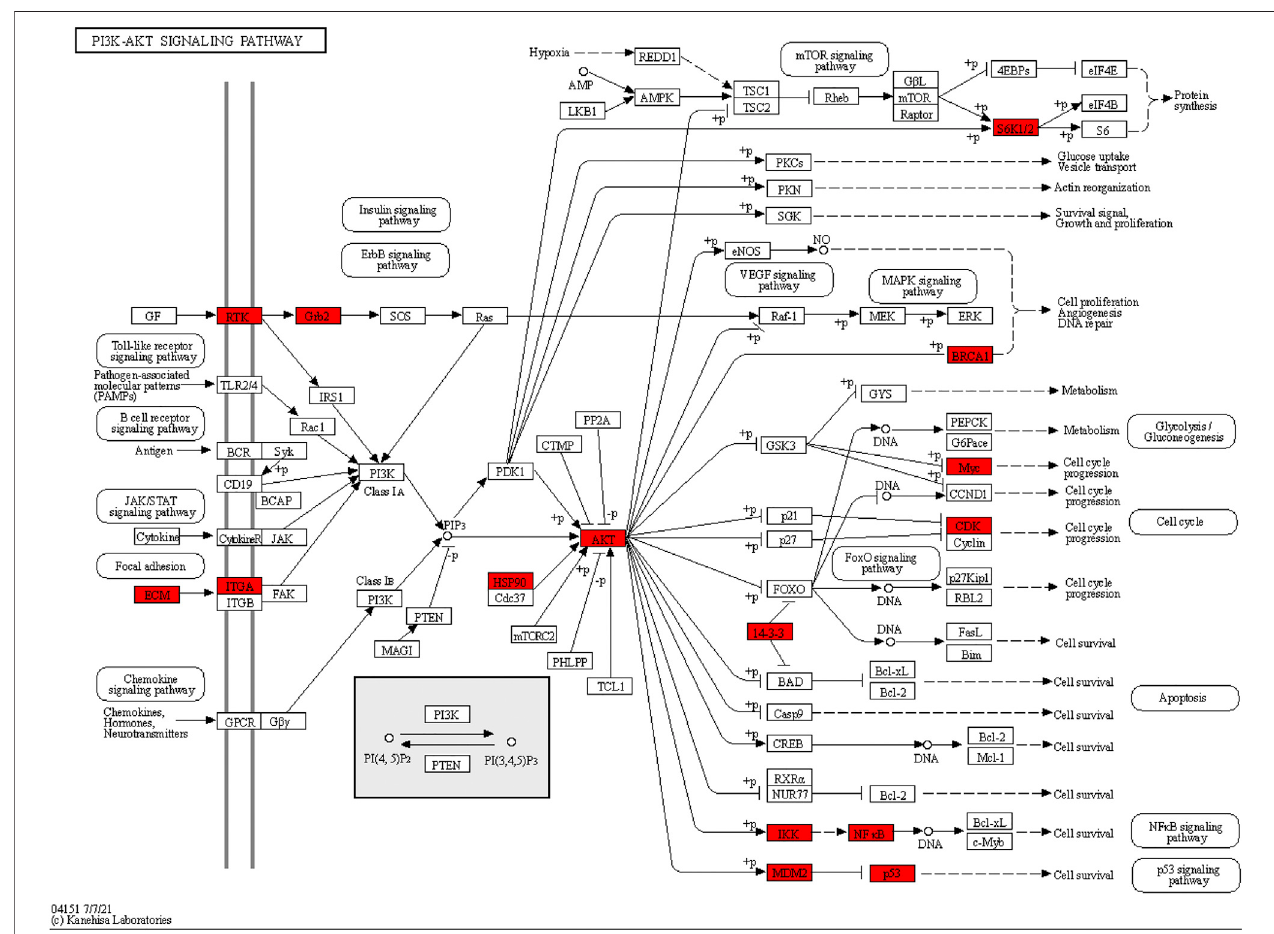
FIGURE 5 | Core targets enriched in the PI3K/Akt pathway. The red nodes represent 15 core targets enriched in the PI3K/Akt pathway.